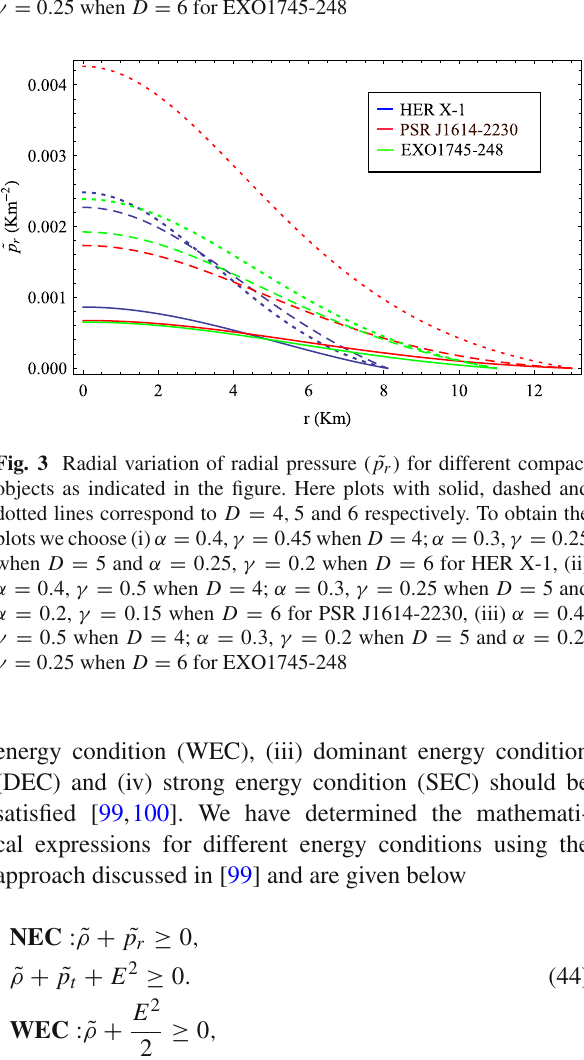
Fig. 2 Radial variation of energy density ( ˜ ρ ) for different compact objects as indicated in the figure. Here plots with solid, dashed and dotted lines correspond to D = 4 , 5 and 6 respectively. To obtain the plots we choose (i) α = 0 . 4, γ = 0 . 45 when D = 4; α = 0 . 3, γ = 0 . 25 when D = 5 and α = 0 . 25, γ = 0 . 2 when D = 6 for HER X-1, (ii) α = 0 . 4, γ = 0 . 5 when D = 4; α = 0 . 3, γ = 0 . 25 when D = 5 and α = 0 . 2, γ = 0 . 15 when D = 6 for PSR J1614-2230, (iii) α = 0 . 4, γ = 0 . 5 when D = 4; α = 0 . 3, γ = 0 . 2 when D = 5 and α = 0 . 2, γ = 0 . 25 when D = 6 for EXO1745-248